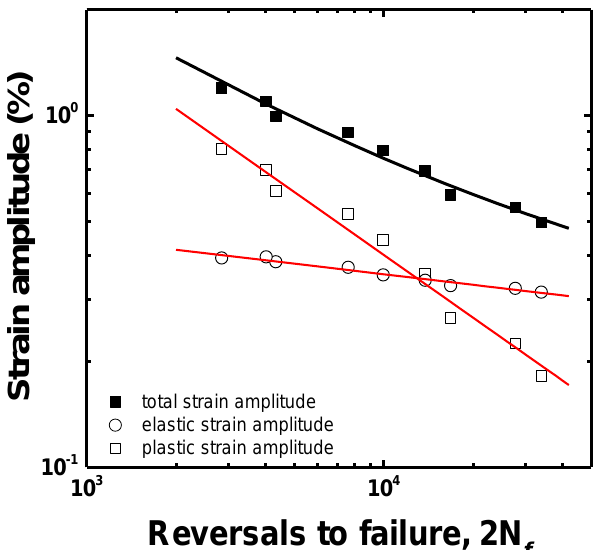
Figure 8. LCF life curve as a function of the number of the reversals to failure. Table 3. LCF parameters of the aged lightweight